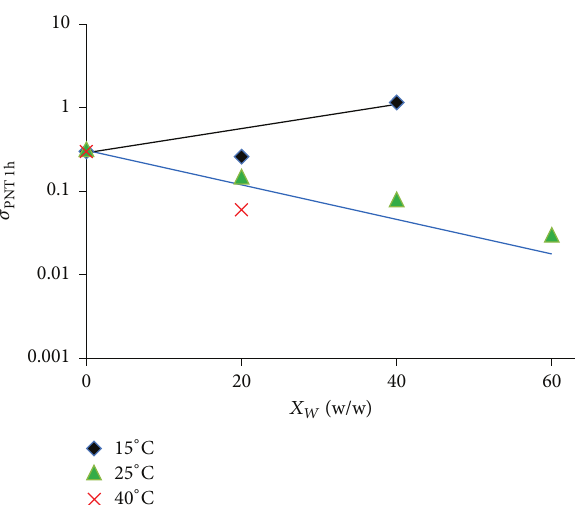
Figure12:Effectofwatercontentonthe1 hPNTvalues,onthesame scale as for 𝜎 SNT (Figure 8). The 𝜎 PNT values are approximately six times larger than the 𝜎 SNT .